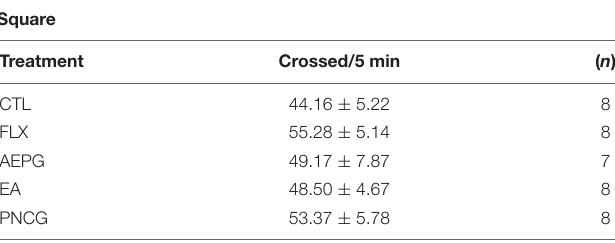
TABLE 1 | Effect of aqueous extract of FLX, AEPG, fractions with PNCG and EA on general motor activity. Square Treatment